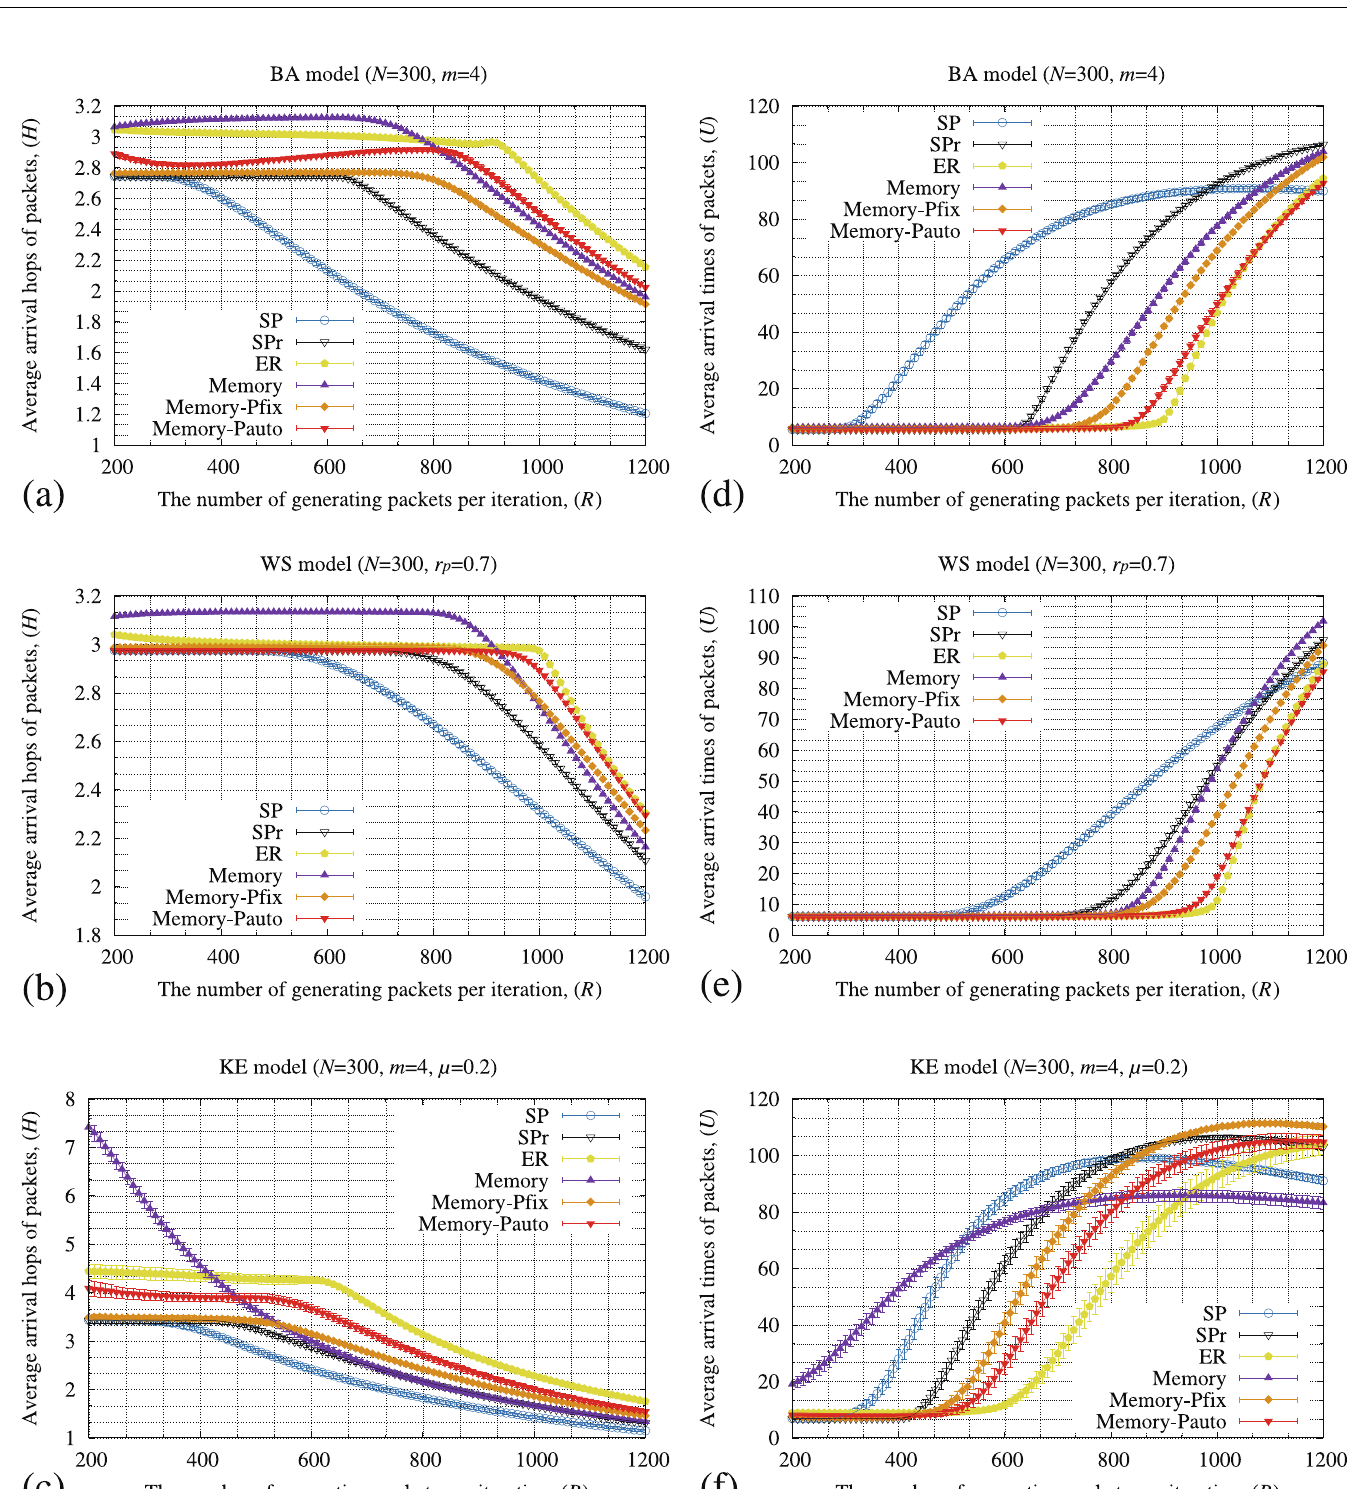
PLOS ONE | https://doi.org/10.1371/journal.pone.0283472 April 19,